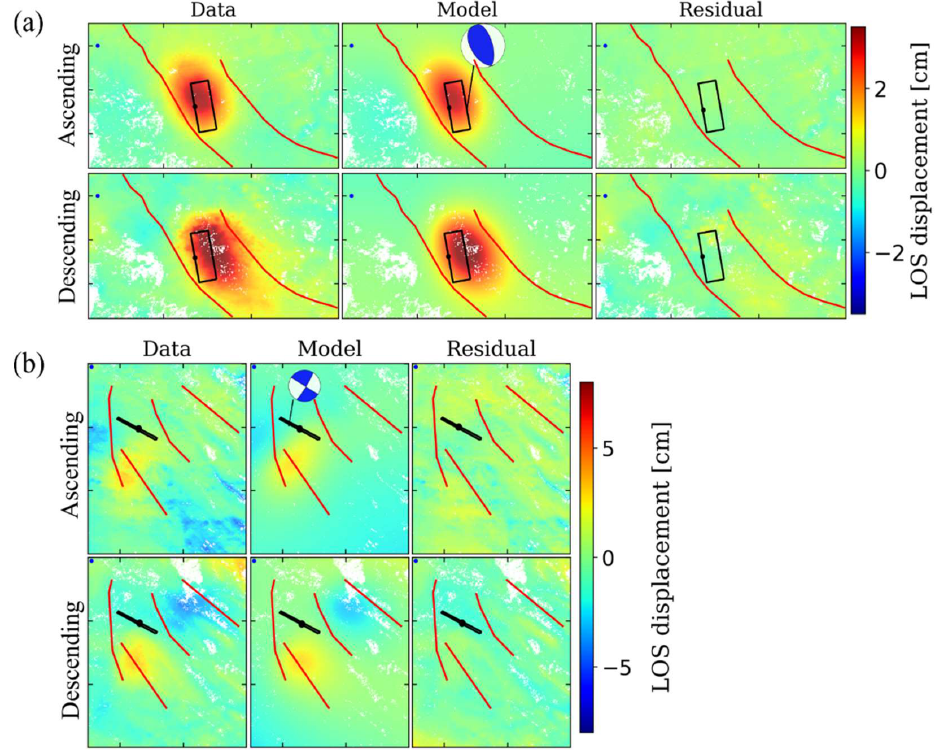
Figure 3. Uniform slip inversion result of aftershock sequence 1, aftershock sequence 2 for ascending data and descending data. ( a ) Aftershock sequence 1, ascending data from 10 January 2018 to 16 January 2018, descending data from 5 January 2018 to 17 January 2018; ( b ) aftershock sequence 2, ascending data from 18 November 2018 to 30 November 2018, descending data from 25 November 2018 to 7 December 2018. Black solid rectangle: best-fitting dislocation. Red lines: nearby faults. Black dot: upper edge of fault. The beach balls for aftershock sequence 1 and 2 are obtained based on the inverted fault parameters. Blue points for aftershock sequence 1 and 2: reference point.